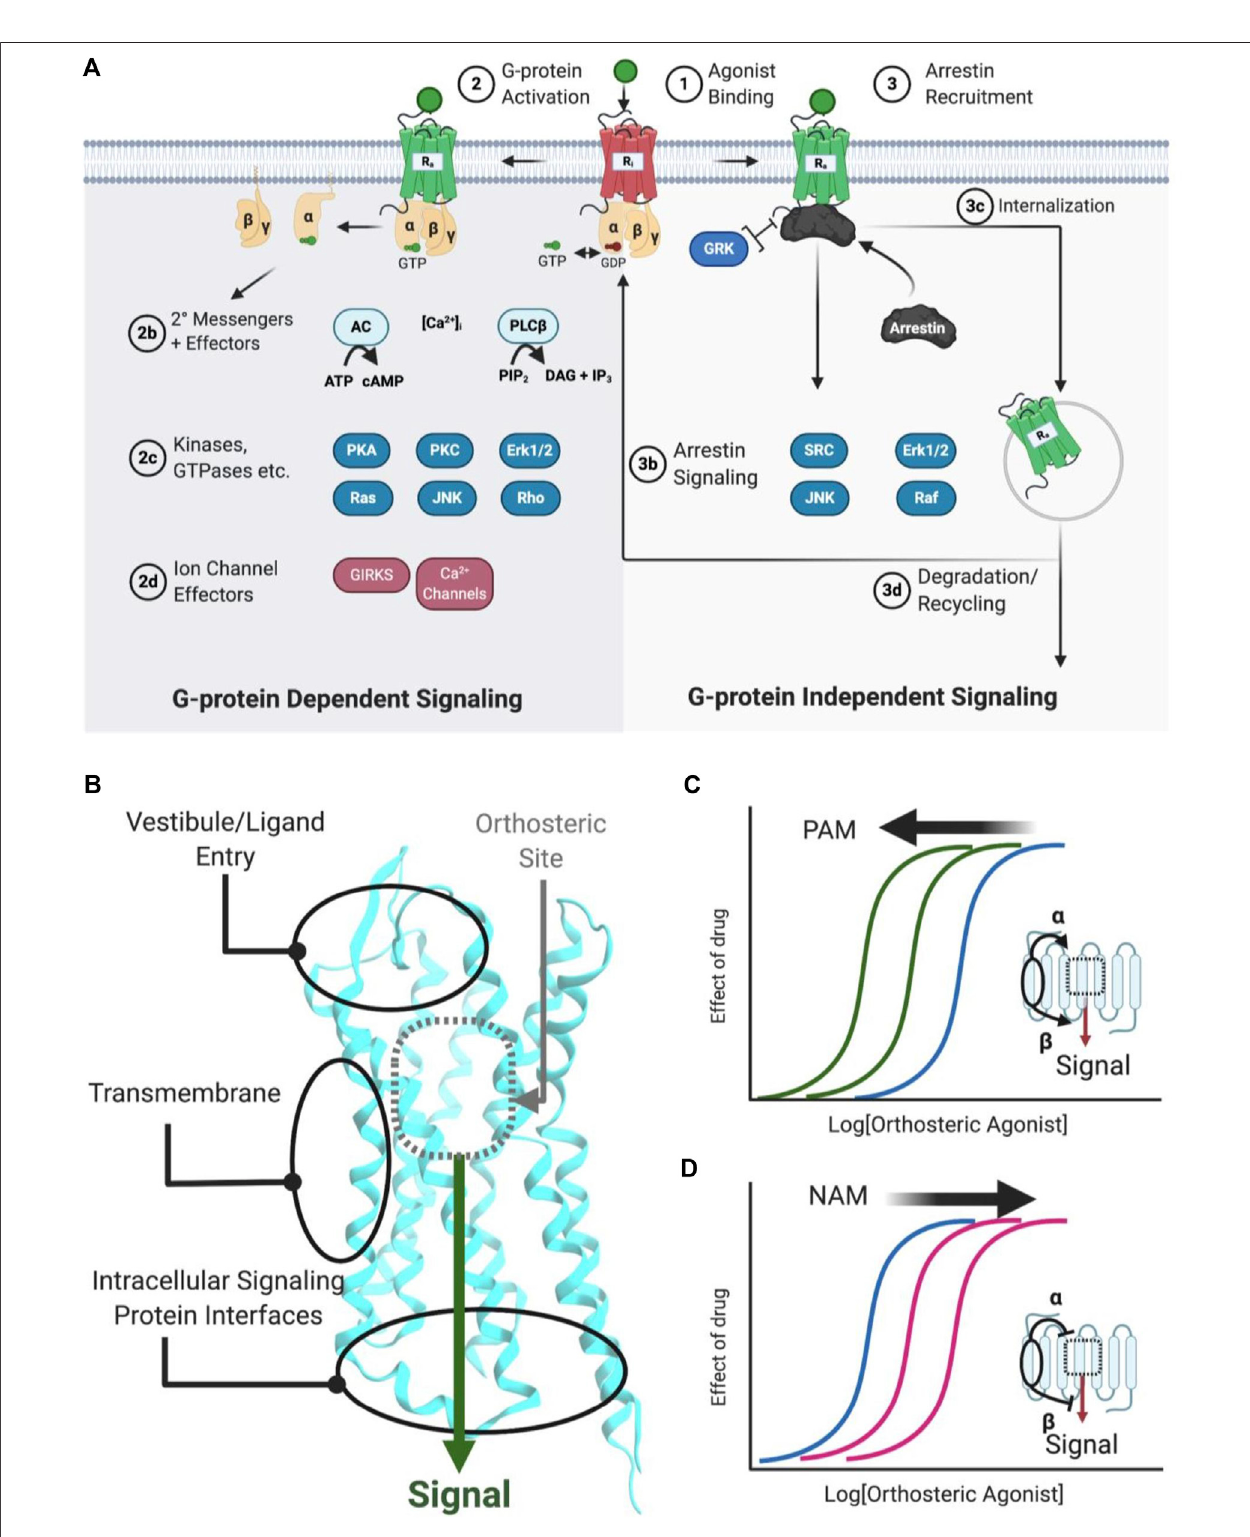
FIGURE1| Simpli fi edschematicofGPCR signalingpathways,AMbindingsites,andpositive/negativeAMs. (A) Common GPCRsignaling pathwaysareactivated by an orthosteric agonist (green circle), which converts an inactive receptor (red, R i ) to an active receptor (green, R a ) (Step 1). R a causes the transducer G-protein to exchange GDP for GTP and modulate various downstream effectors, such as kinases, ion channels, and enzymes (Step 2). Classically, signaling is terminated by phosphorylation, arrestin recruitment, and internalization (Step 3). Furthermore, arrestins can scaffold signaling pathways. Biased agonists can favor speci fi c